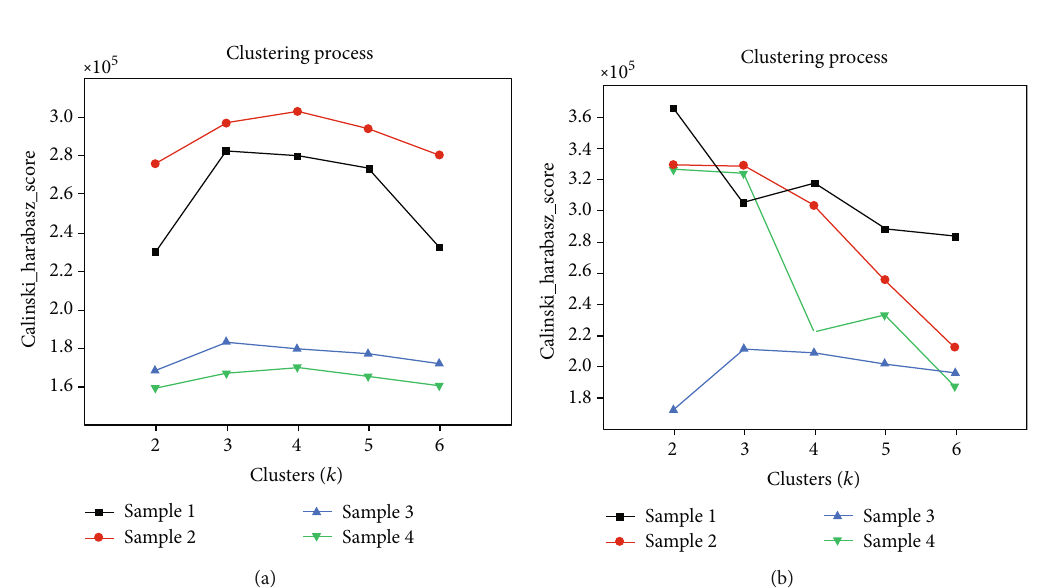
Figure 15: Clustering process under Calinski-Harabasz evaluation score: (a) traditional K -means algorithm under Calinski-Harabasz evaluation score; (b) adaptive clustering process under Calinski-Harabasz evaluation